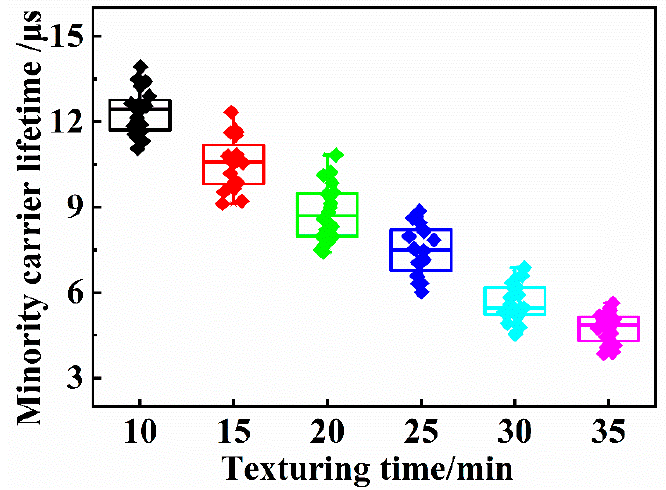
Figure 8. Minority carrier lifetimes of the wafers. (the minority carrier lifetime of the wafers gradually decreases with increasing texturing time.)